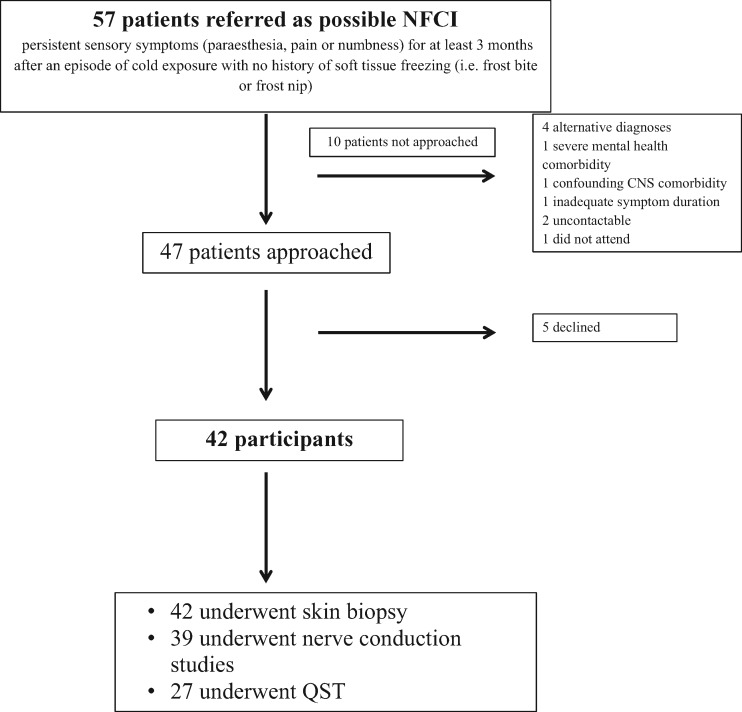

Participant recruitment pathway. Flow diagram of the recruitment of study participants.